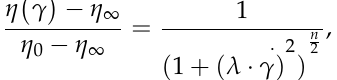
Figure 2. Experimental (measured) viscosity flow curves fitted to Ostwald or power-law model ( a ) and Carreau model ( b ).